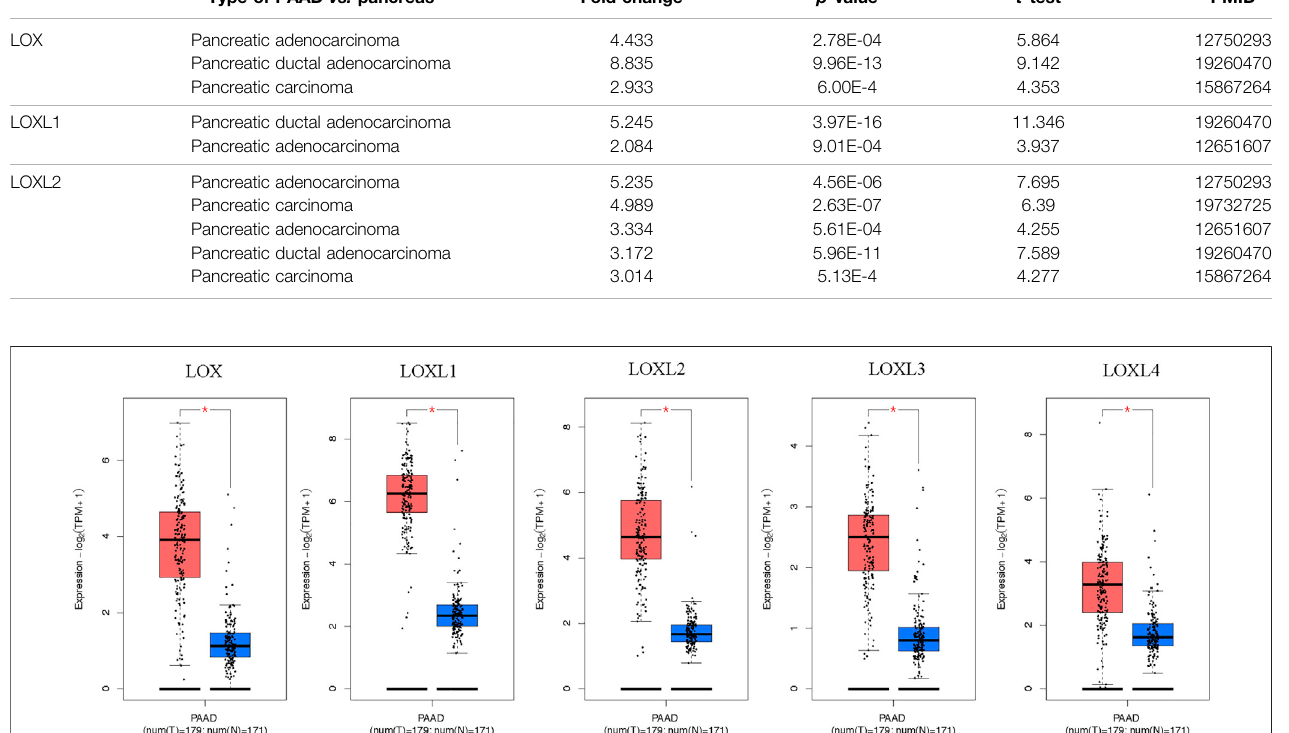
Frontiers in Molecular Biosciences |